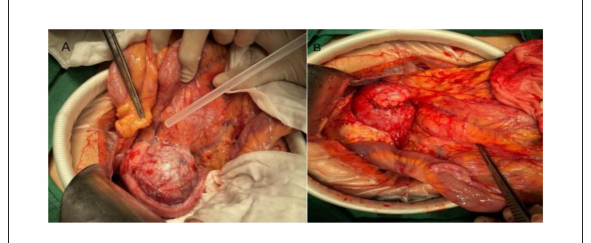
FIGURE3 Intraoperative image of exophytic SPN in the head of pancreas. (A) Exogenous SPN in the head of the pancreas. (B) Picture after tumor